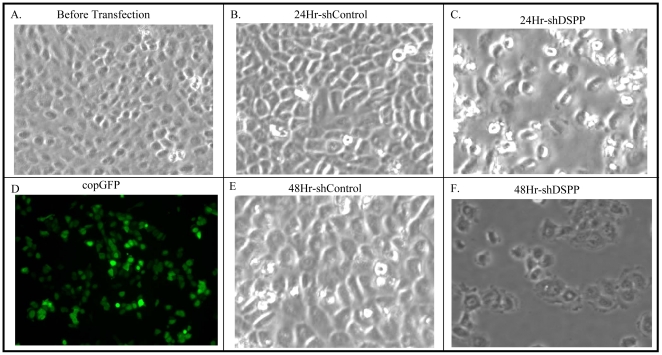
Transient lentiviral-mediated DSP-shRNA knockdown results in altered morphology of OSC2 cells.(A) OSC2 cells prior to lentiviral-transduced transfection with DSP-ShRNA exhibiting characteristic morphology of viable epithelial tumor cells in culture. (B, E) Scrambled (control) sequence-transfected OSC2 cells at 24- and 48 h exhibiting viable epithelial cells and morphology comparable to (A). (C, F; illustrative areas) DSP-shRNA transfection OSC2 cells exhibiting significantly increased number of cells with loss of cell-cell contact, more rounded and irregular outline, prominent nuclear blebbing, and cellular disintegration consistent with those of effete and dying cells at 24- and 48-h, respectively. (D) copGFP transfected OSC2 cells confirm very high transfection efficiency (green fluorescence).